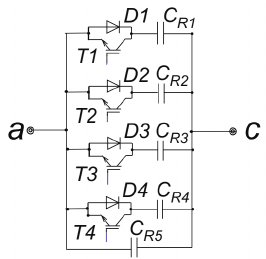
Figure 4. Electronic semiconductor switches for setting the power level.